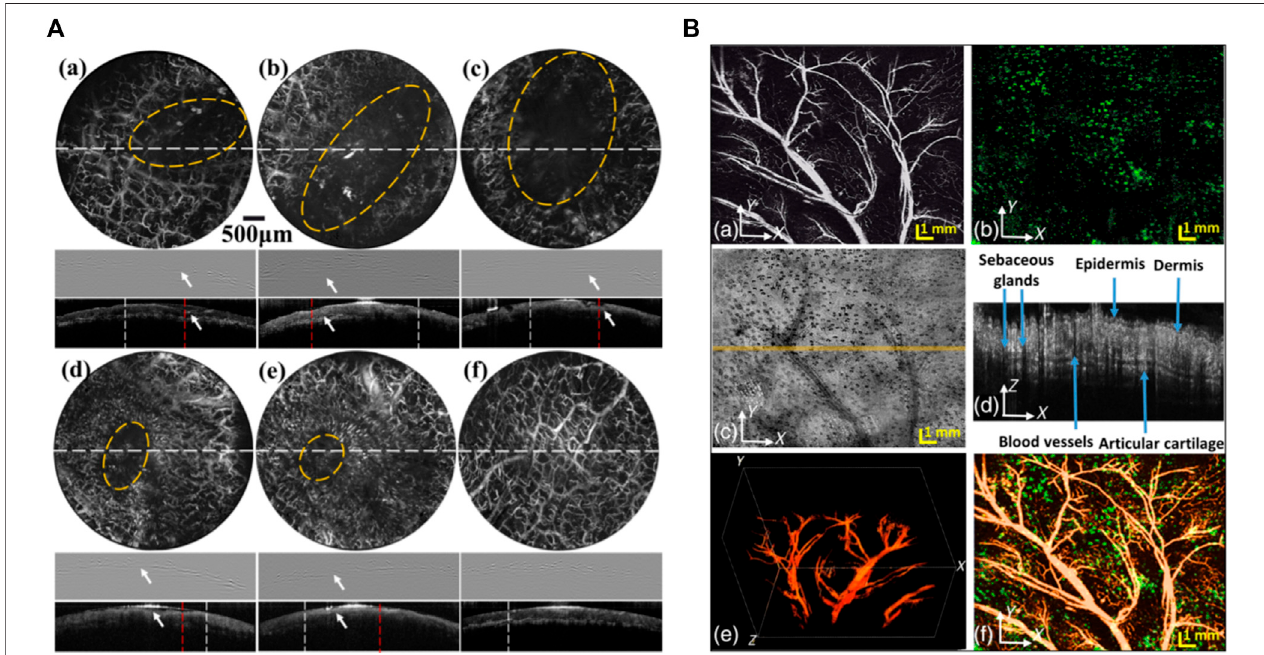
FIGURE 4 | (A) PAM and OCT results of the microvascular distribution and microstructures of the lower lip during the healing process of an ulcer wound. Row 1 in PAMimagesofthelipfromday1today6.Row2PAMB-scansofthelipalongthedashedwhitelinesinRow1.Row3OCTB-scansofthelipalongthedashedwhitelines in Row1. The wounds are indicated by the yellow circles in PAM images and the white arrows in PAM B-scans. Scale bars: 500 µm. Reprinted with permission from [120]; (B) simultaneously acquired PAM,confocalmicroscopy(CFM), and OCTimages ofamouse earwithdynamic focusing. (A) PAMimage; (B) CFM image; (C) OCTimages; (D) OCTB-scanatthelocationmarkedinpanel; (C) byasolidline; (E) PAM3-Dimagereconstruction;and (F) fusedPAMprojectionandCFMimages;bar: 1 mm. Reprinted with permission from